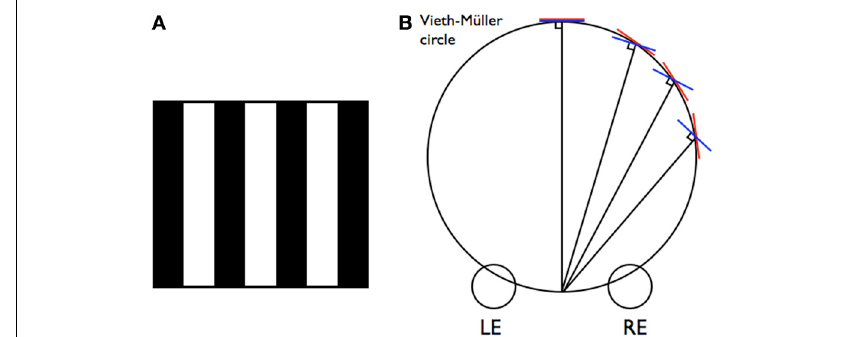
FIGURE 1 | (A) Demonstration of the venetian blind effect. When viewed with a neutral density filter (or polarized sunglasses) covering one eye, the white bars appear to slant in the direction toward the covered eye. (B) The deviation between the horopter (red lines) tangent to the Vieth-Müller circle, and the normal (blue lines) which is at right angles to the line of sight, increases with increasing visual field eccentricity. In central vision the tangent and the normal